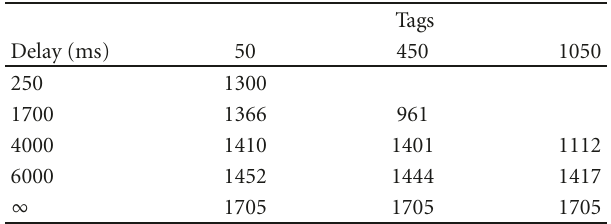
Table 6: The table shows how lifetime (days) for a tag varies with a chosen delay and di ff erent number of